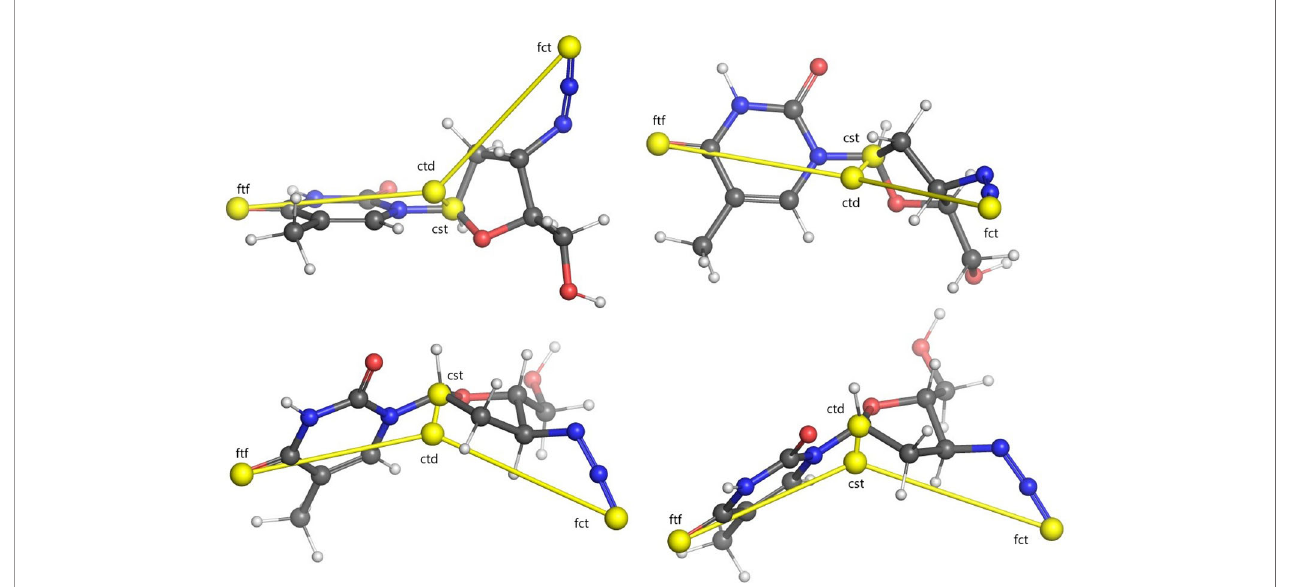
FIGURE 1 | Illustration of USR centroids computed for a sample conformer of the Zidovoudine molecule. Centroids are indicated with yellow spheres. Lines between every centroid and the molecular centre are displayed for clarity. Four different rotations of the molecule are illustrated. Legend: ctd, molecular centroid; cst, closest atom to ctd; fct, furthest atom to ctd; ftf, furthest atom from